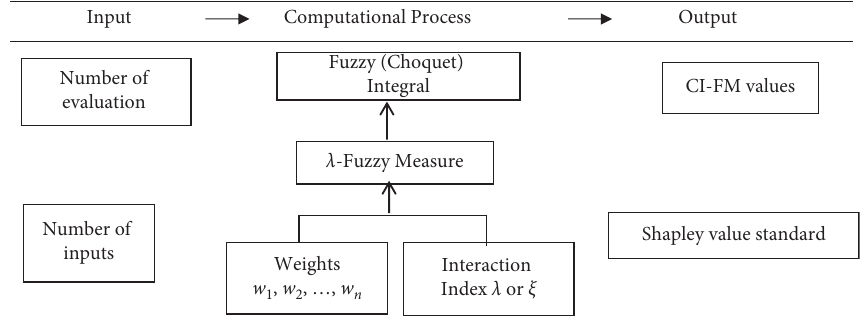
Figure 1: Framework of